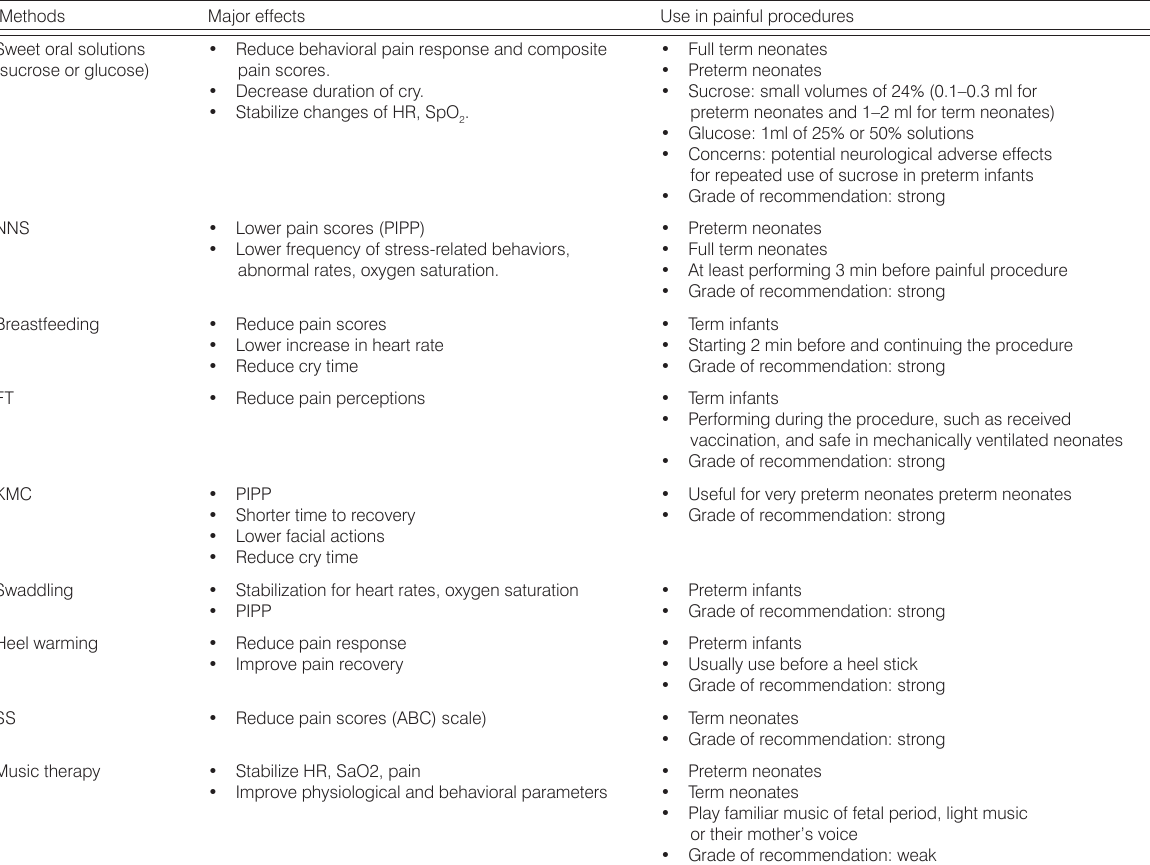
Table 1. Non-pharmaceutical interventions for neonatal pain